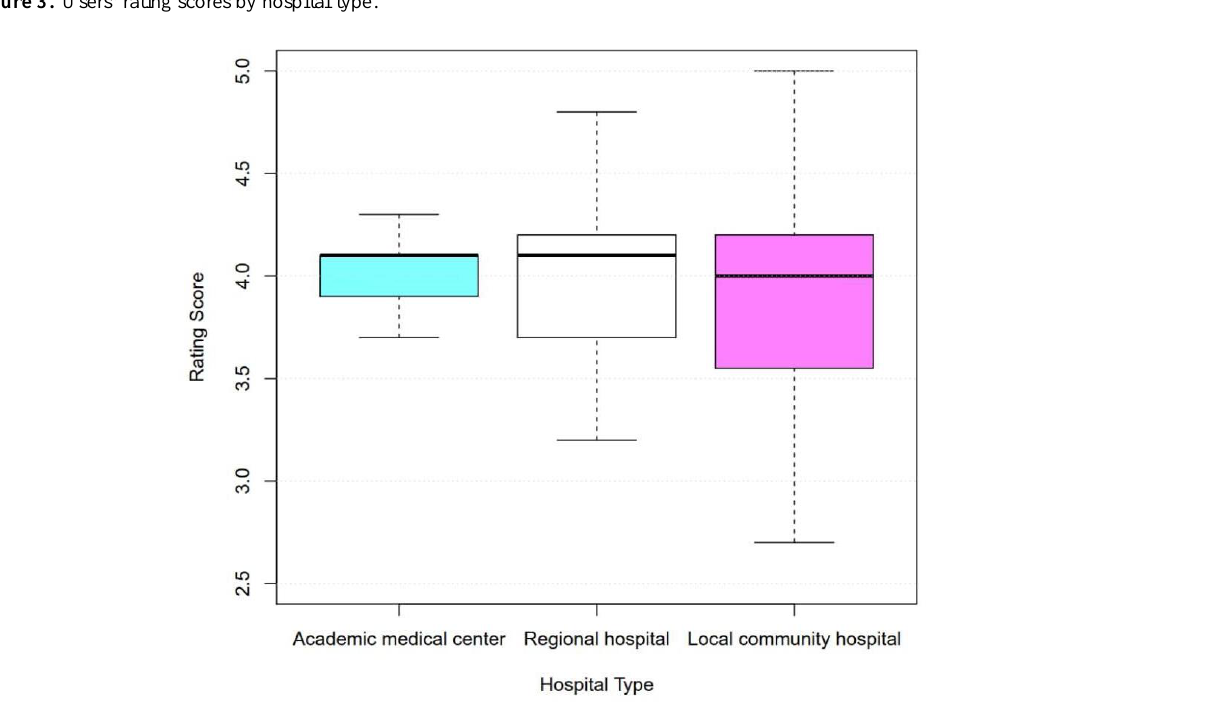
Figure 3. Users’rating scores by hospital